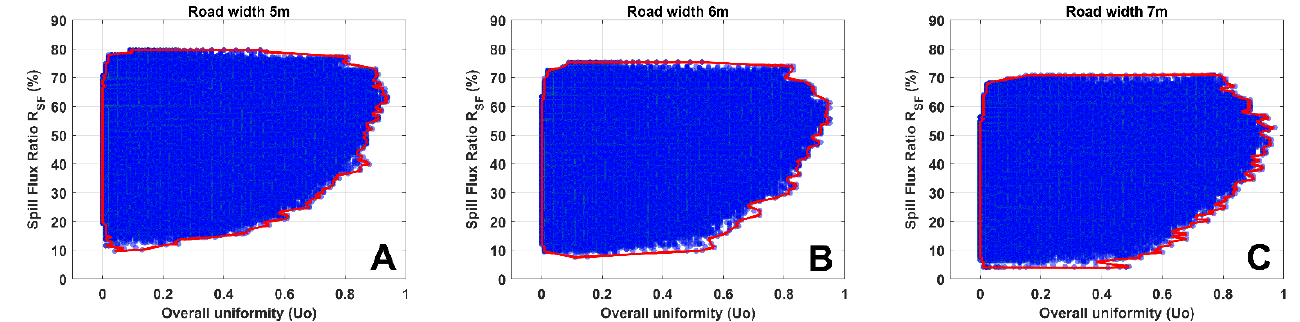
Figure 15. Overall uniformity of illuminance vs. spill flux ratio, simulation results for cases. The graphs include all potential pole arrangements, as shown in Table 1. The red boundary line indicates the technically possible solutions. The bottom side of each sub-figure A, B, and C of Figure 15 reveals the lowest percentage of spill luminous flux that is technically possible (given the selected optics) to achieve the corresponding uniformity: ( A ) results for road width of 5 m; ( B ) results for road width of 6 m; ( C ) results for road width of 7 m.